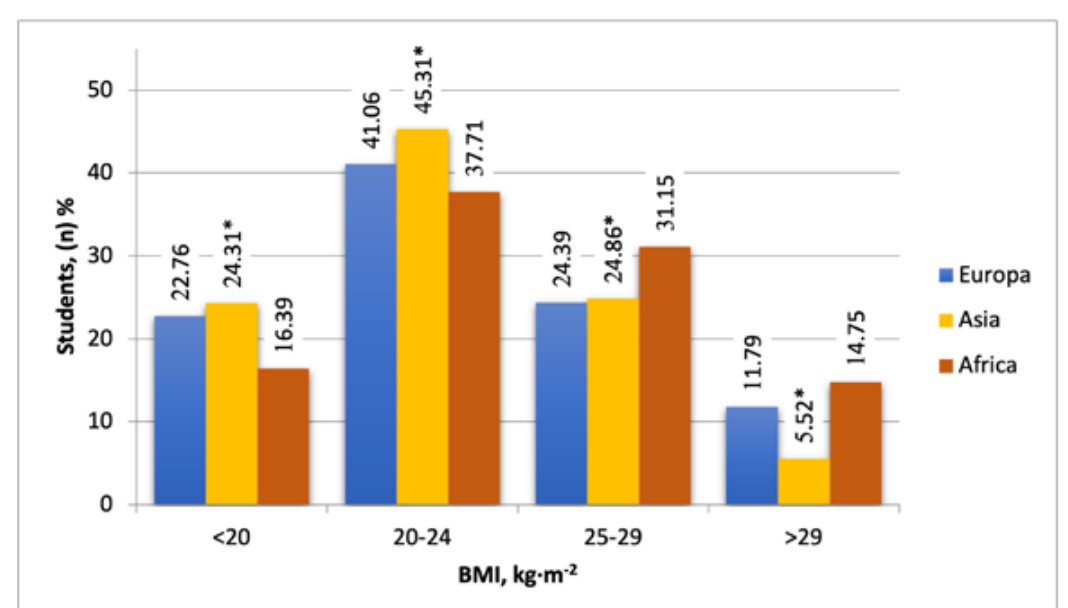
Figure 1. Frequency of distribution of students according to BMI (kg·m -2 ): * - differences between representatives of Asia and Africa at the level of p <.1 (based on Table 3. Longitudinal and circumferential dimensions of the body of students, X̄ (SE) Indicators